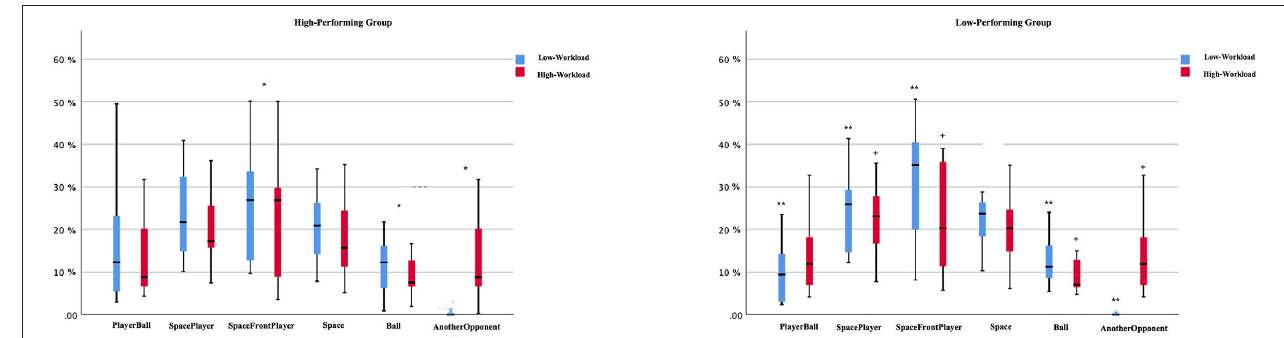
FIGURE 2 | Mean percentage (%) of time spent viewing each fixation location across workload conditions for both defensive tactical accuracy groups. * Significant differences within high-performing group between SpaceFrontPlayer and Ball and AnotherOppnent in both workload conditions ( p < 0.05). ** Significant differences within low-performing group between SpacePlayer and SpaceFrontPlayer, and PlayerBall, Ball, and AnotherOppnent in low-workload conditions ( p < 0.05). + Significant differences within low-performing group between SpaceFrontPlayer and SpacePlayer and Ball and AnotherOppnent in high-workload conditions ( p < 0.05).